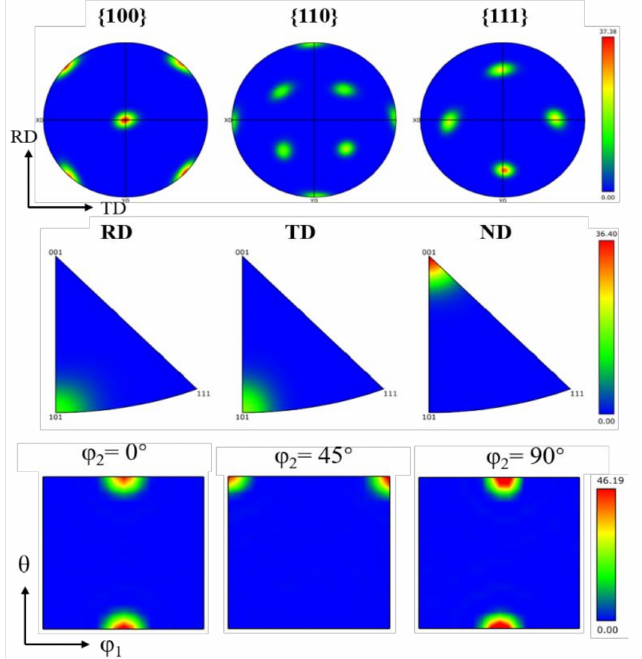
Figure 8. EBSD results of Mo 5 SiB 2 single crystals after compression at 1200 ◦ C and 0.01 s − 1